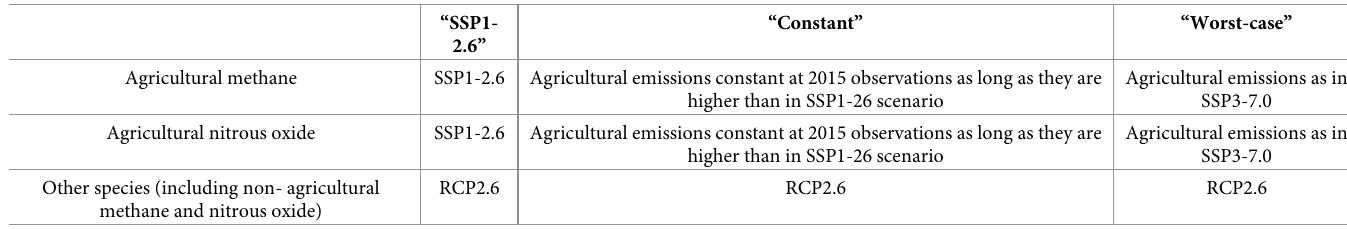
Table 1. Details of alternative scenarios used in this study.